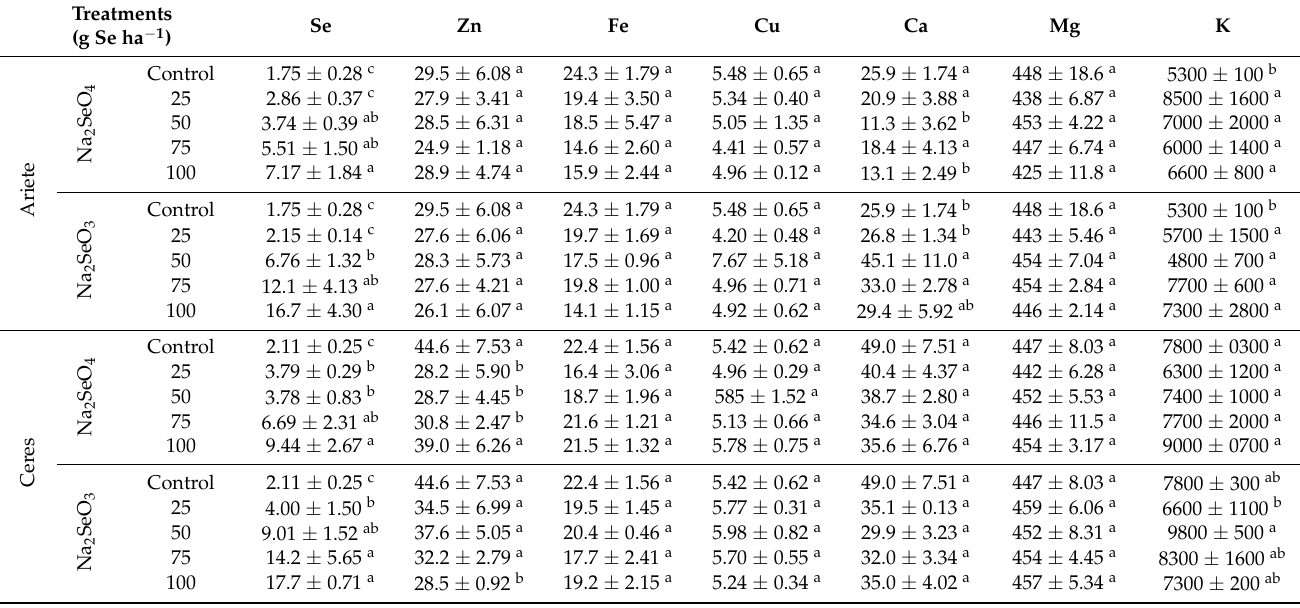
Table 2. Selenium, zinc, iron, copper, calcium, magnesium and potassium concentrations in the brown grains of O. sativa cultivars. Treatments (g Se ha − 1